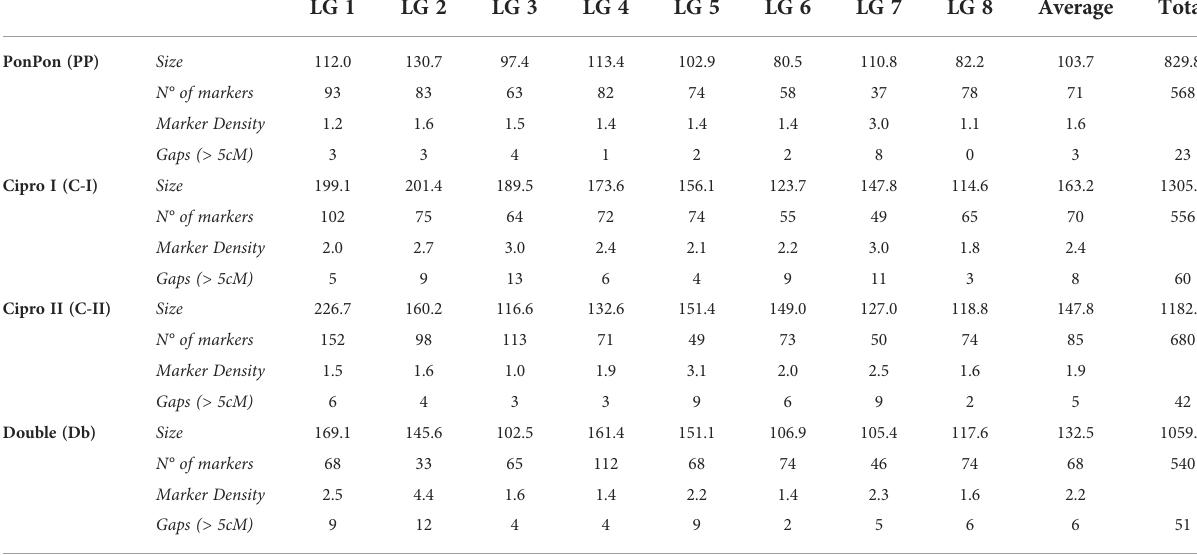
TABLE 1 Statistics of the four linkage